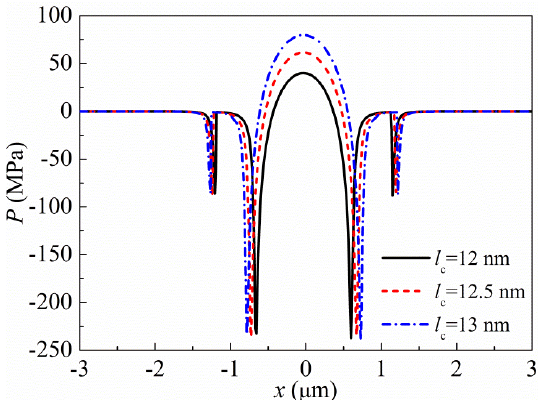
Adhesion force F a , Contact force F c and ( b ) Flying height FH .